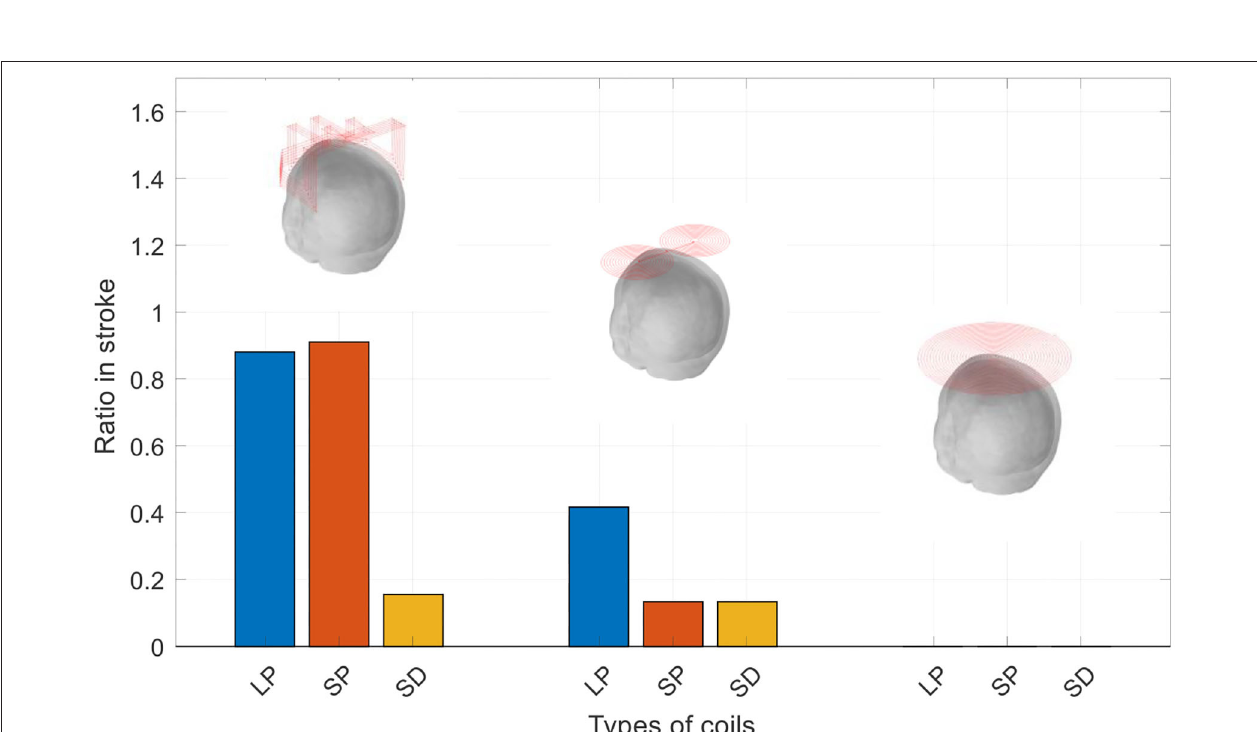
FIGURE 6 | The mass of stroke